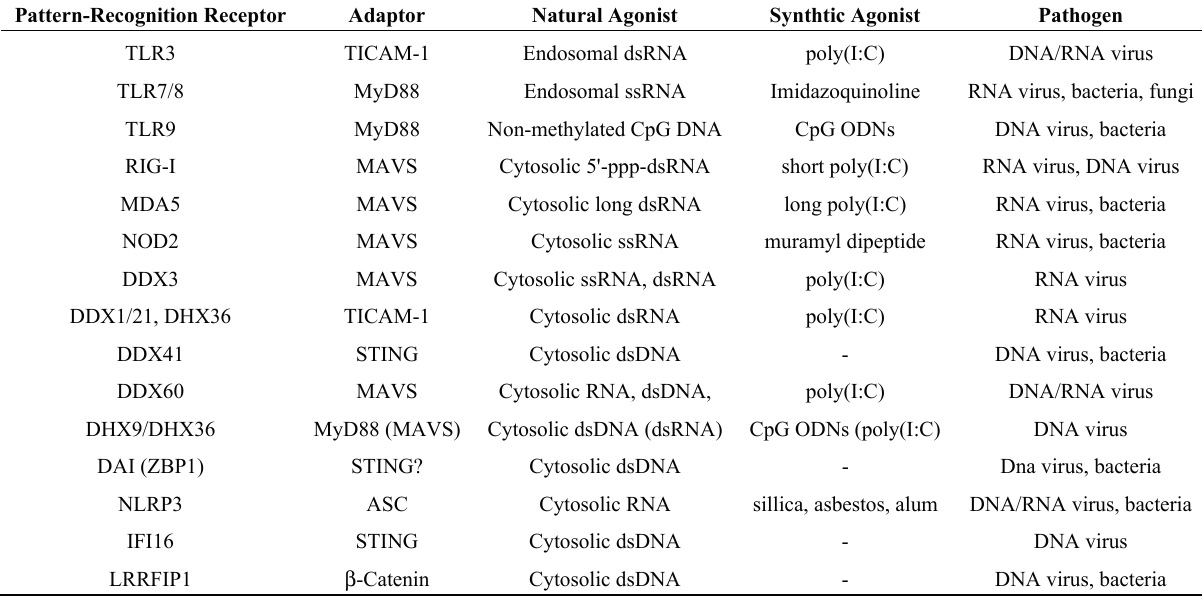
Table 1. Nucleic acid sensors involved in IFN-inducing innate immune response. Pattern-Recognition